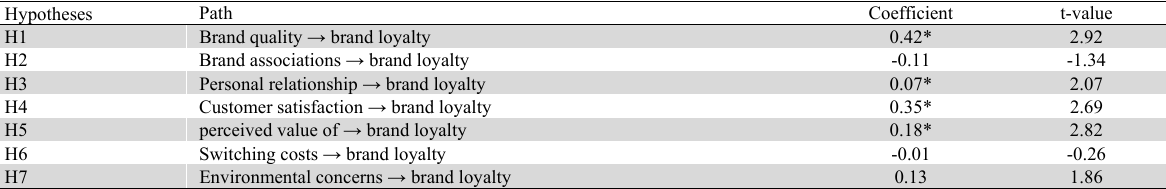
Path Coefficient